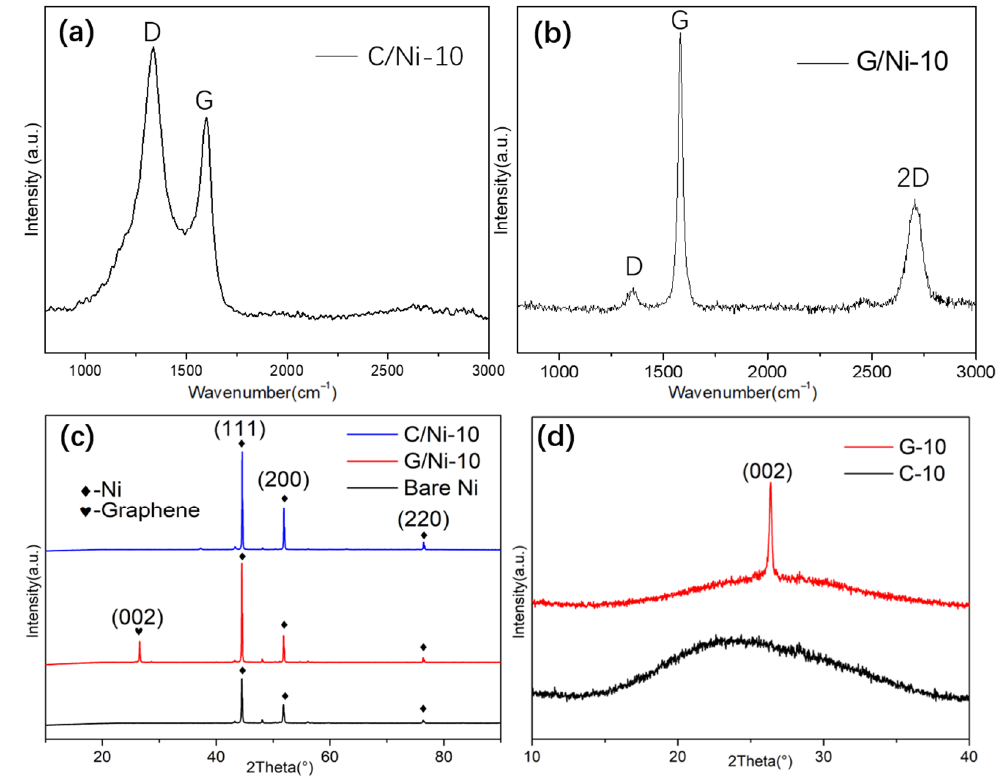
Figure 2. Raman spectra of C/Ni-10 ( a ) and G/Ni-10 ( b ), (where D band represents disordered carbon, G band represents graphitic carbon, and 2D band is relative to the vibration mode of the two photonic lattices rather than the defect); XRD patterns of C/Ni-10 and C-10 ( c ), and ( d ) G/Ni-10.